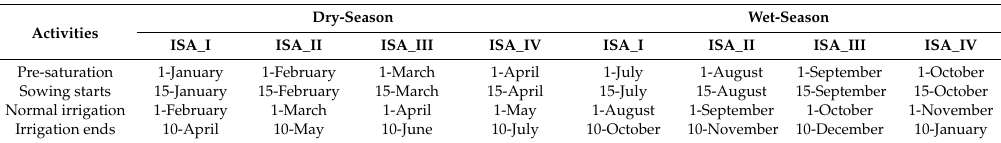
Table 1. Present crop calendar and distribution of irrigation supplies in Tanjung Karang Rice Irrigation